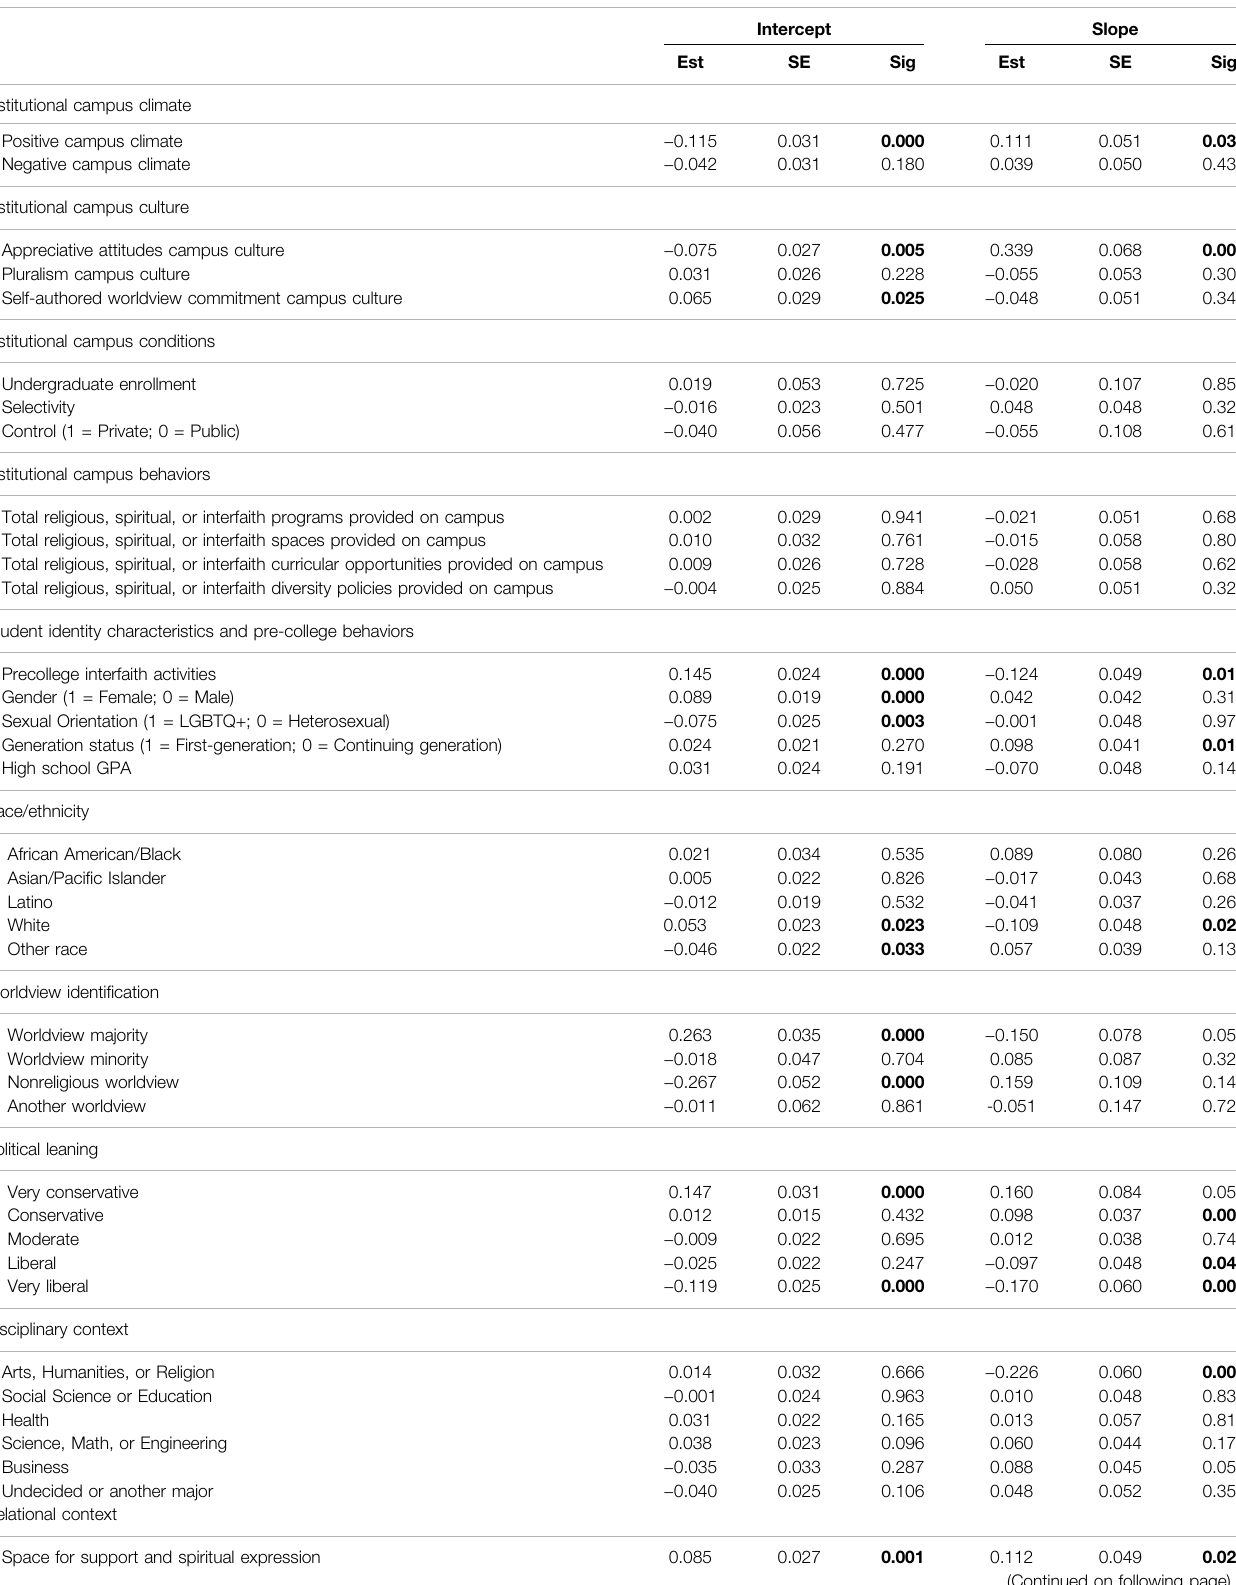
TABLE 3 | Predictors of appreciative attitudes toward evangelical